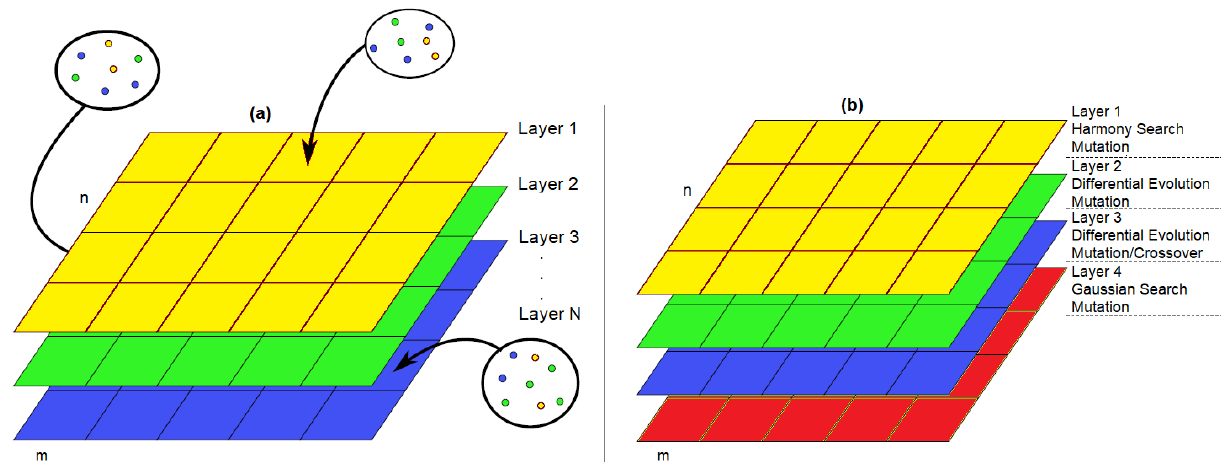
Figure 4. ( a ) Reef’s setting process in CRO-SL. Each potential solution to the problem (larva) tries to settle down in any substrate, regardless of its origin substrate. ( b ) Example of layered reef and their different search strategies implemented (mutations and/or crossovers on each